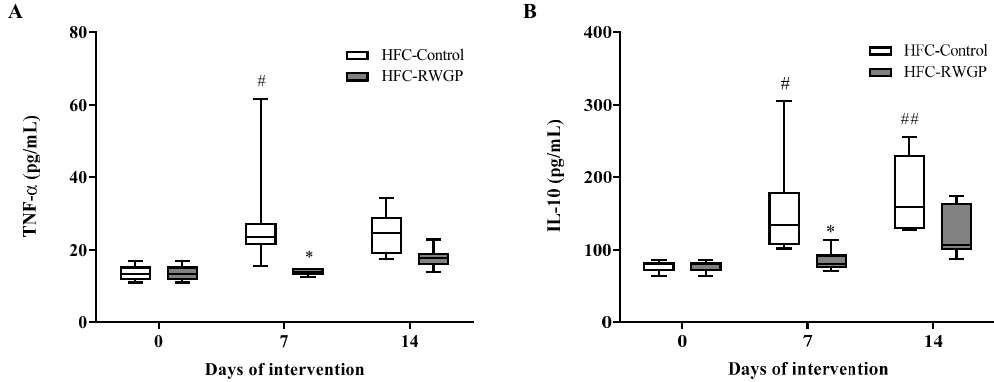
Figure 3. Impact of RWGP supplementation on plasma inflammation markers of SR-B1 KO / ApoER61 h / h mice fed with atherogenic diet. ( A ) TNF- α and ( B ) IL-10 levels at baseline and after 7 and 14 days of feeding HFC-supplemented diet. Data are shown in box plots (box, 25th to 75th percentiles; whiskers, median and IQR) ( n = 5–7). # p < 0.01 and ## p < 0.01 compared to day 0; * p < 0.01 vs. HFC-Control based on two-way ANOVA.